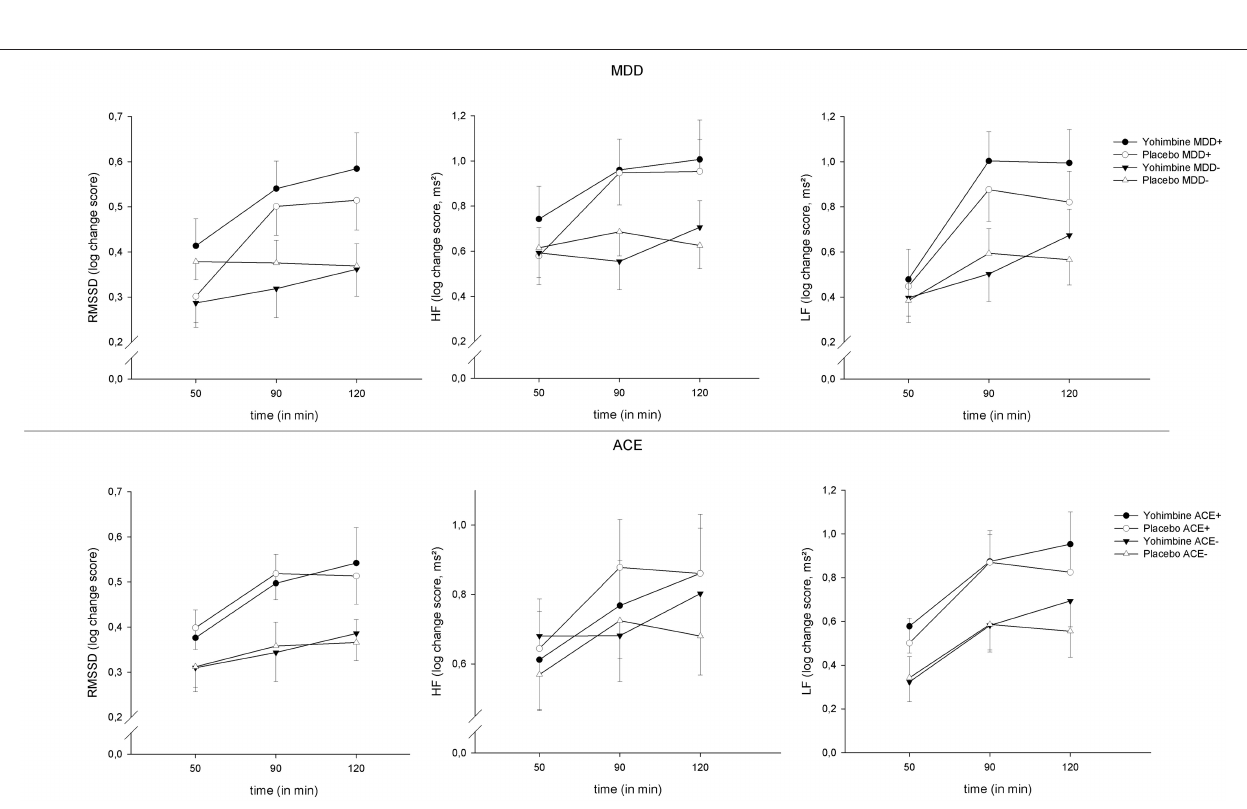
FIGURE 2 | HRV reactivity 50, 90, and 120min after yohimbine administration, separate for MDD (top) and ACE (bottom), and RMSSD (left), HF-HRV (center), and LF-HRV (right), means ± 1SEM.